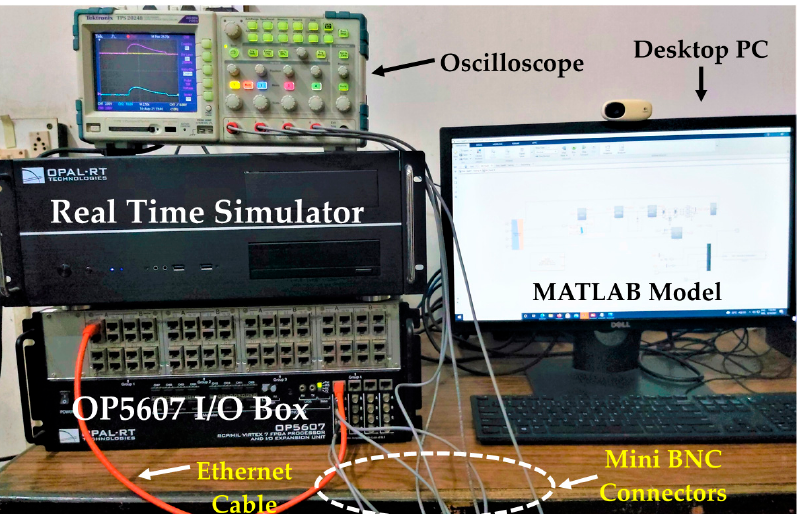
Figure 24. OPAL RT RTS Test Bed. Table 8. Example cases for various types of frequency events verified in the OPAL RT real-time simulation environment.